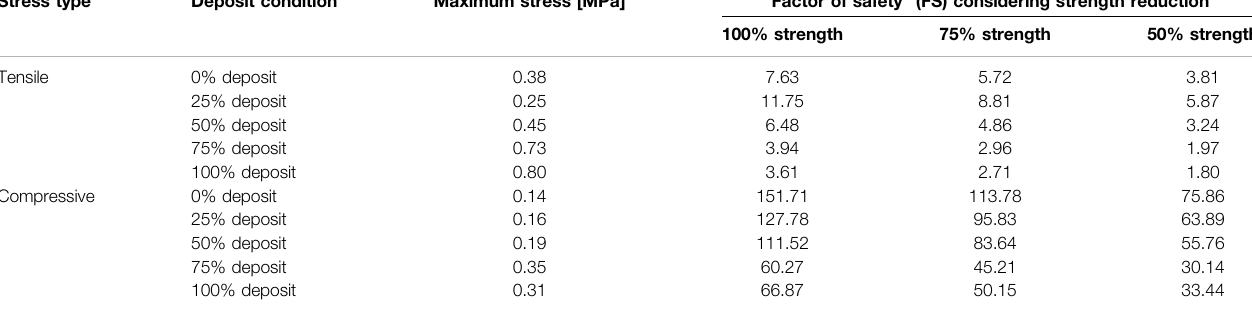
TABLE 4 | Results of structural stability